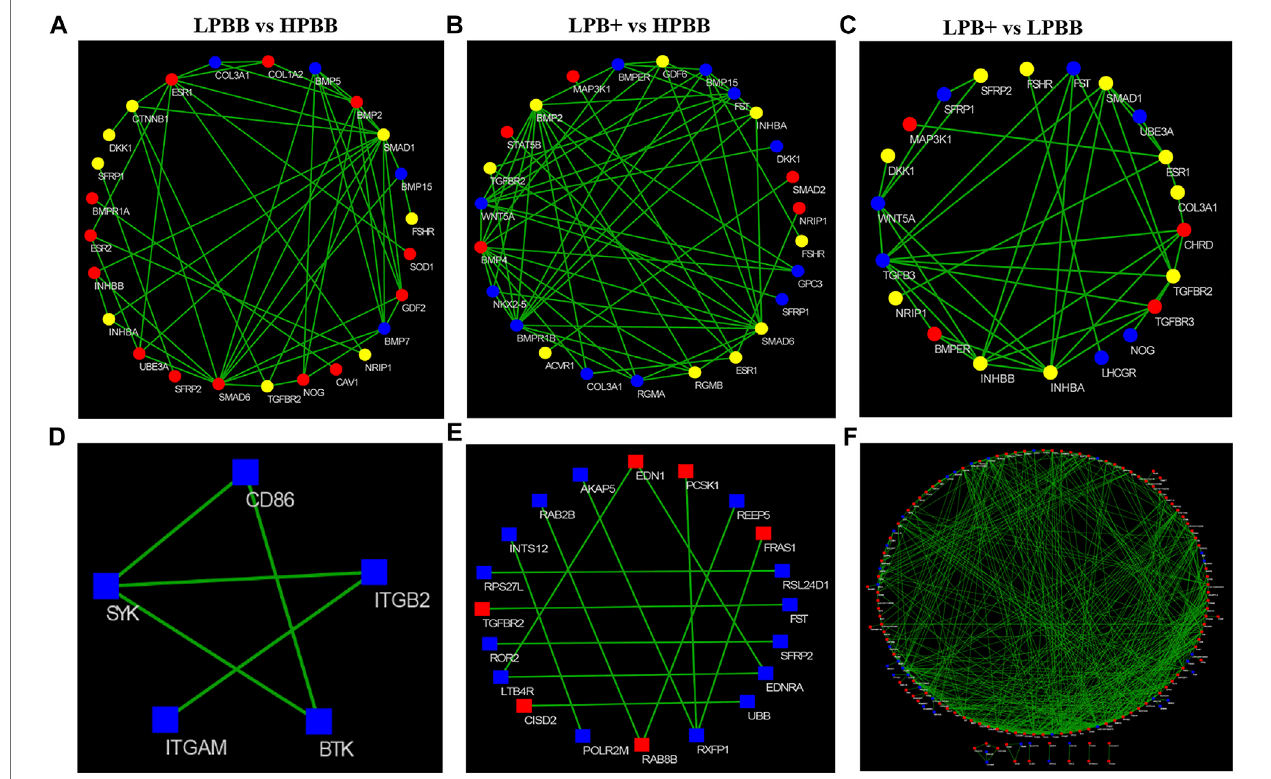
FIGURE 6 | Construction of the network of DMGs and DEGs related to female reproduction. (A – C) Red and blue colors represent strong-hyper and strong-hypo, respectively. Yellow color represents the coexisting strong-hyper and strong-hypo. (D – F) Red and blue colors represent up- and down-regulated, respectively. (A,D) LPBB vs. HPBB; (B and E) LPB + vs. HPBB; and (C,F) LPB + vs. LPBB groups.